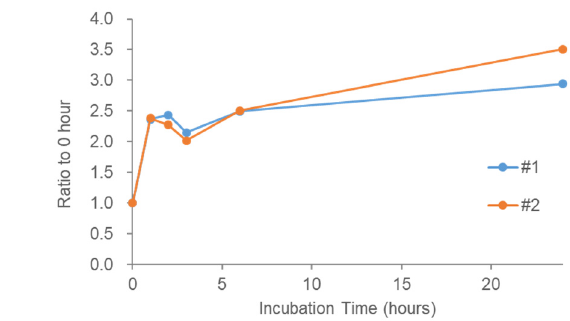
Figure 4. Stability of phosphatidic acid (PA) (36:2) in human serum during 37 °C incubation. A standard stock of PA (18:1/18:1) was dissolved in serum and incubated for the indicated time. Two replicate samples with 5.1 ng of PA in 30 μ L pooled serum were tested. ( left ) PA (36:2) and ( right ) LPA (18:1) were analyzed using liquid chromatography/mass spectrometry (LC/MS) after lipid extraction. The X -axis shows incubation time (h) and the Y -axis shows values relative to those at 0 h. Two replicate sample results (#1 and #2) are shown as lines.